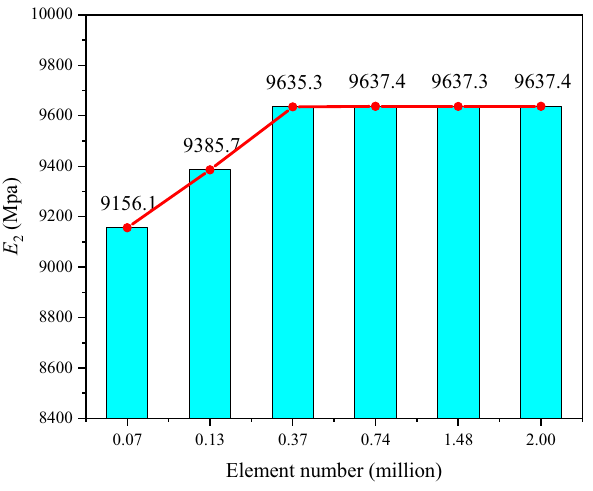
Figure 8: The element convergence veri fi cation in accordance with the elastic modulus E 2 . The blue bar shows the results for di ff erent numbers of elements, and the red line shows the trend of results.